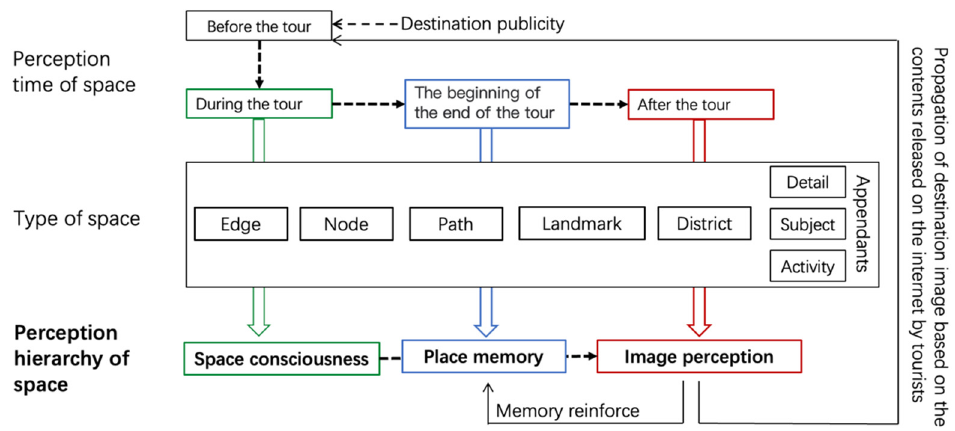
Figure 14. The framework of tourists’ multi-level spatial cognition (source: authors).